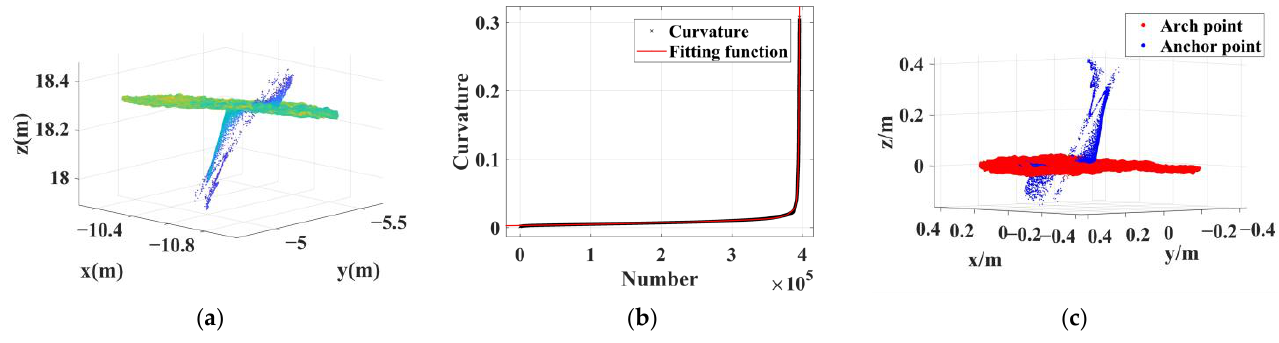
Figure 10. Extraction results of long anchor rod with significantly mixed pixels. ( a ) Dense point cloud. ( b ) Curvature fitting results. ( c ) Extraction results; red points belong to the arch roof, and the blue points belong to the anchor rod.